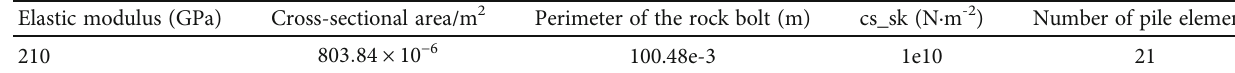
Figure 7: (a) Schematic diagram of the simulation scheme with single bedding separation; (b) the numerical model when x Table 1: Simulation model input parameters for pile elements.